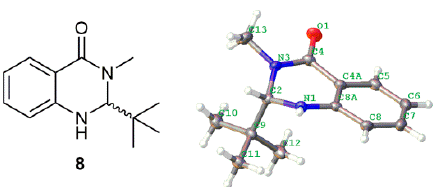
Figure 1 . Structure and single-crystal X-ray diffraction of quinazolinone ( 8 ) showing the pseudo-axial conformation of tert-butyl group.